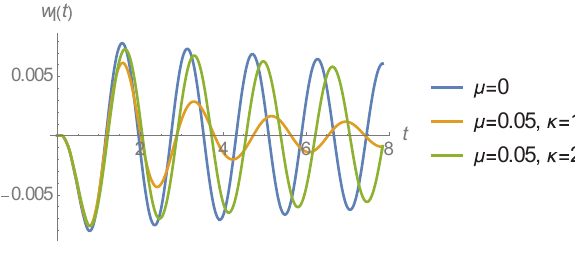
Figure 4: Deflection of the structure in the midspan for two absorbers with different κ .